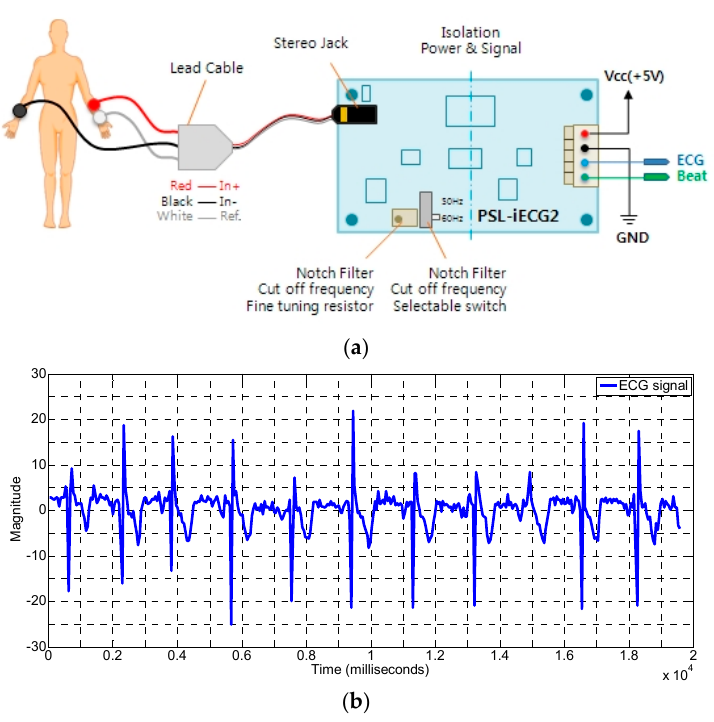
Figure 15. ( a ) Measurement setup for the ECG signal acquisition; ( b ) The signal obtained from the ECG sensor module PSL-iECG2 (measurement reference device).